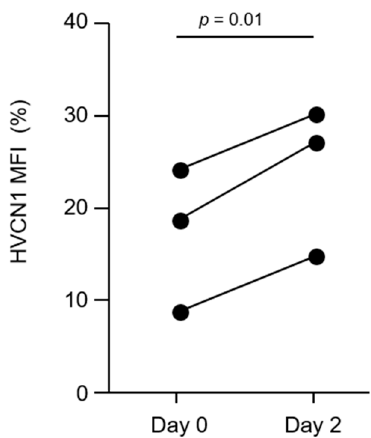
Figure 4. AAT augmentation therapy increases HVCN1 neutrophil plasma membrane expression. HVCN1 membrane expression of AATD neutrophils before (day 0) and 2 days after augmentation therapy (day 2) assessed by flow cytometry. HVCN1 expressing neutrophils were significantly higher on day 2 after therapy ( p = 0.014, n = 3, Student’s paired t test).